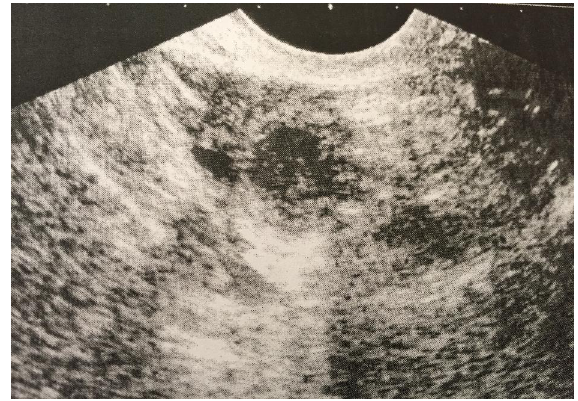
Figure 1: Dominant follicle in right ovary on transvaginal sonography performed on day 14 of menstrual cycle (mean diameter: 23.9 mm)